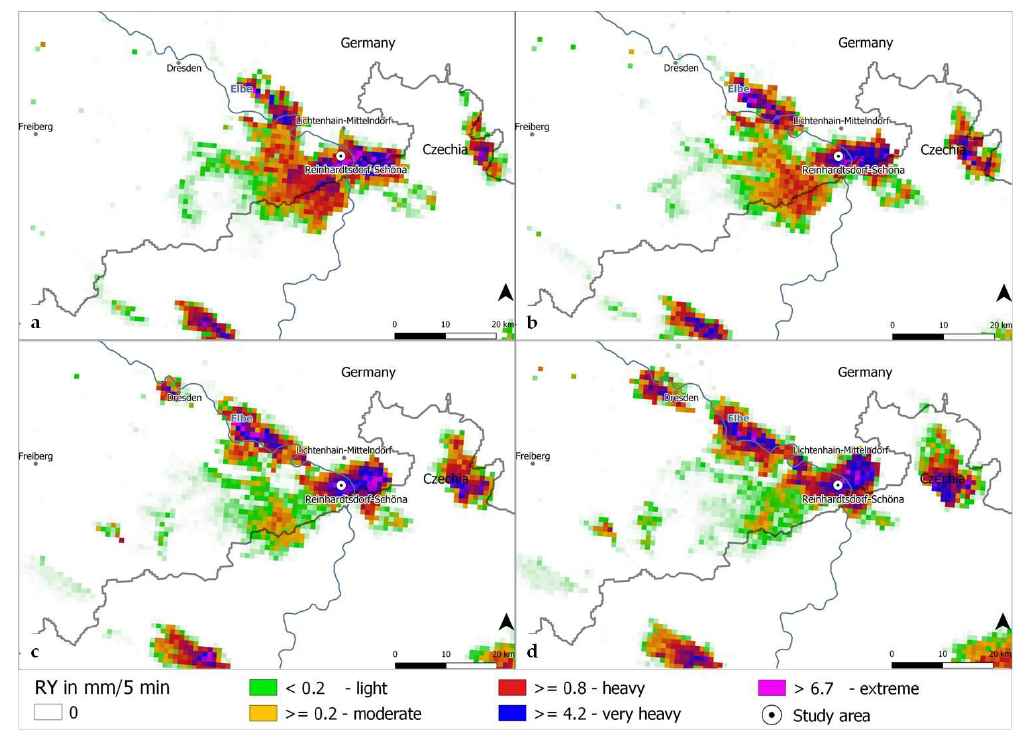
Figure 9. The selected storm event in 5-min time steps on 31 May 2016 from ( a ) 2:20 p.m., ( b ) 2:25 p.m., ( c ) 2:30 p.m. to ( d ) 2:35 p.m.